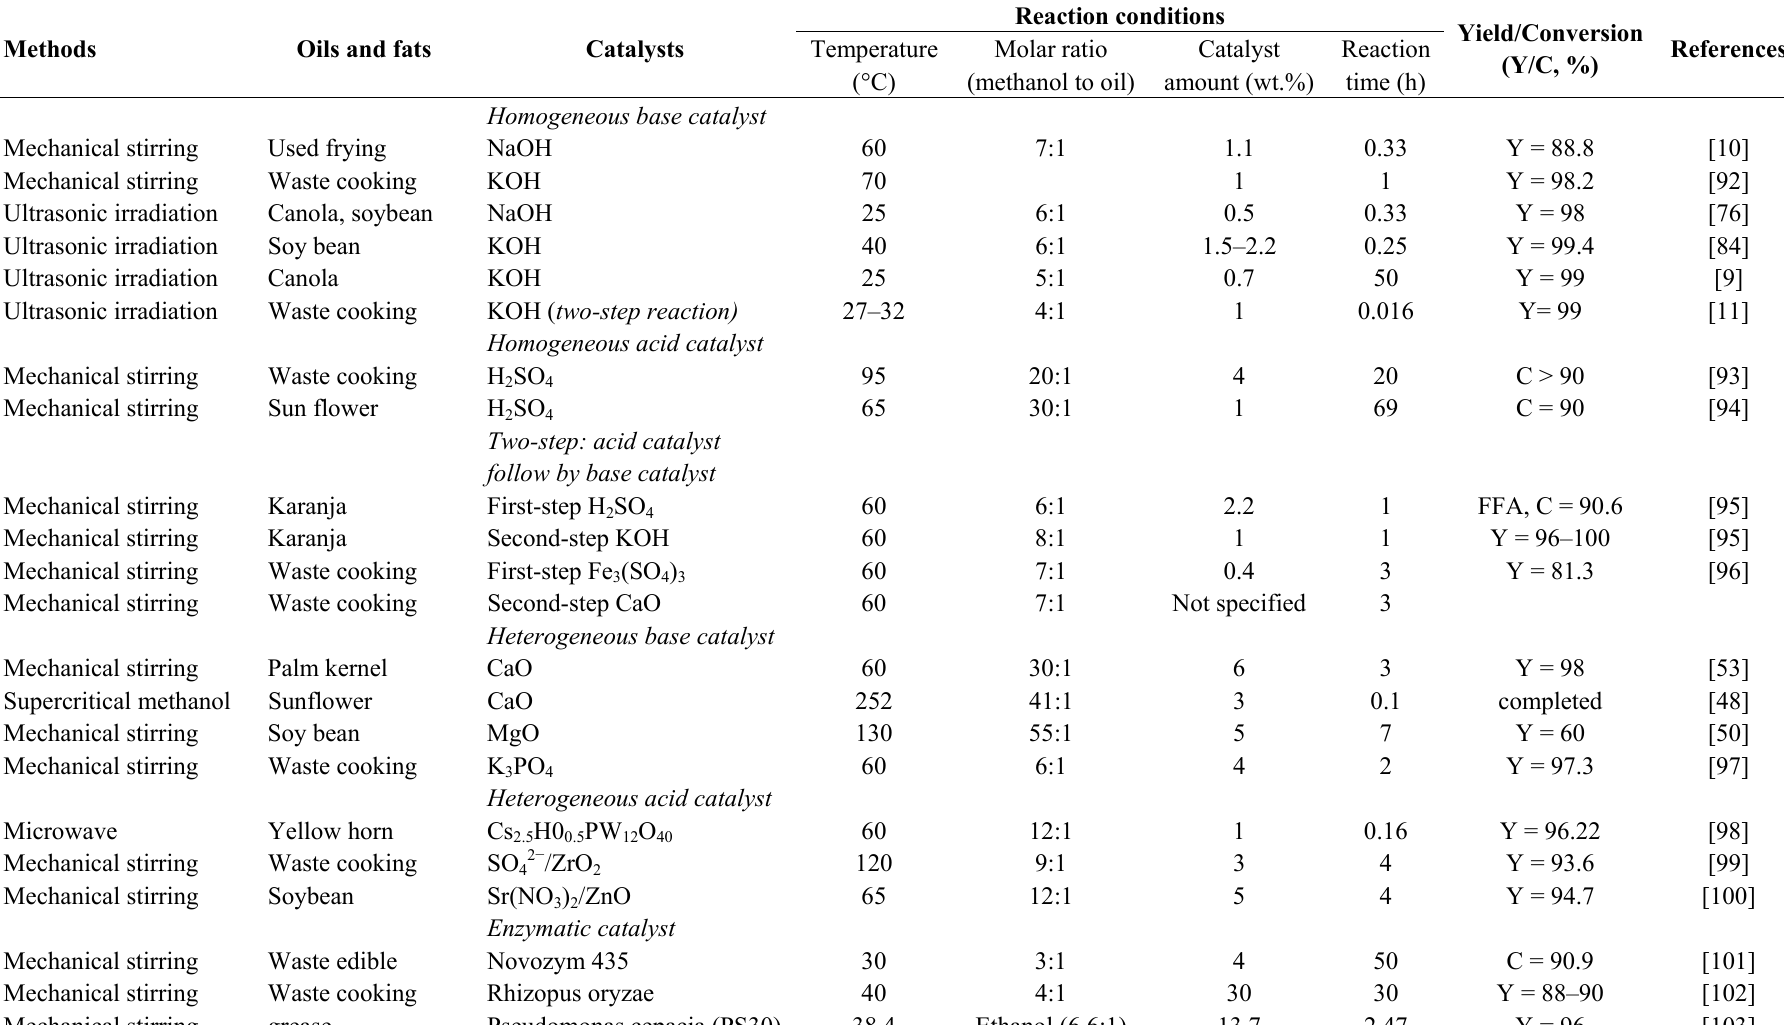
Table 5. Summary of production methods, kind of catalysts and reaction conditions on the fatty acid methyl ester (FAME) yield. Methods Oils and fats Catalysts